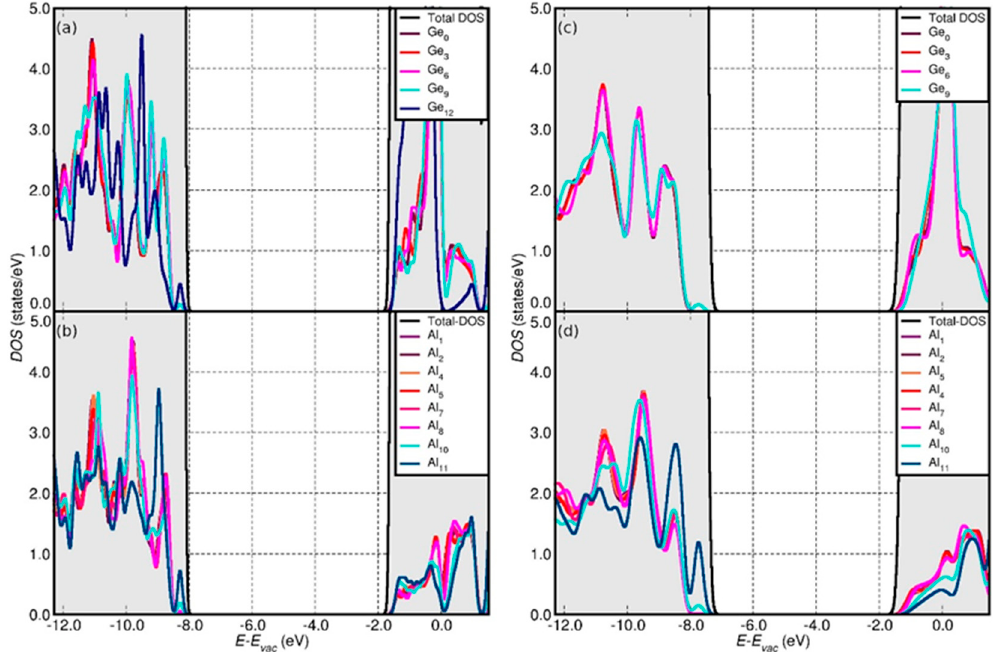
Figure 5. Calculated (vacuum-aligned) DOS, Al ring and Si ring LDOS for the OH- ( a,b ) and H 2 O ( c,d )-terminated AlGe hex-7 model.